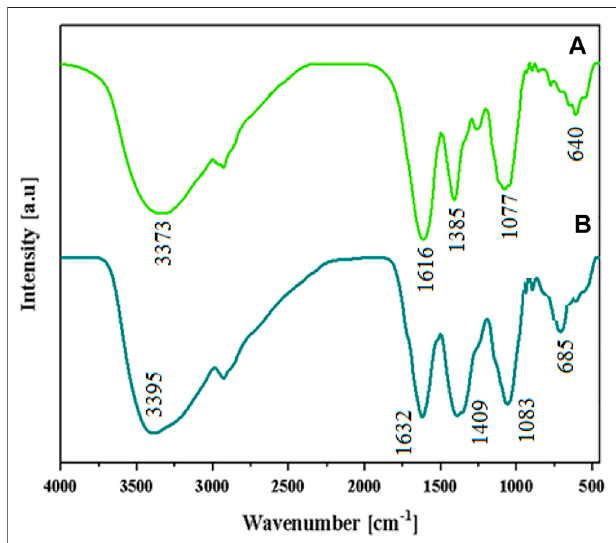
FIGURE 6 | SEM photographs of (A) cotton fabrics, (B) cotton fabric treated by 10%o.w.f. TA and (C) treated cotton fabric by 10% o.w.f. TA and 5%%o.w.f. Ag after application of natural dye.